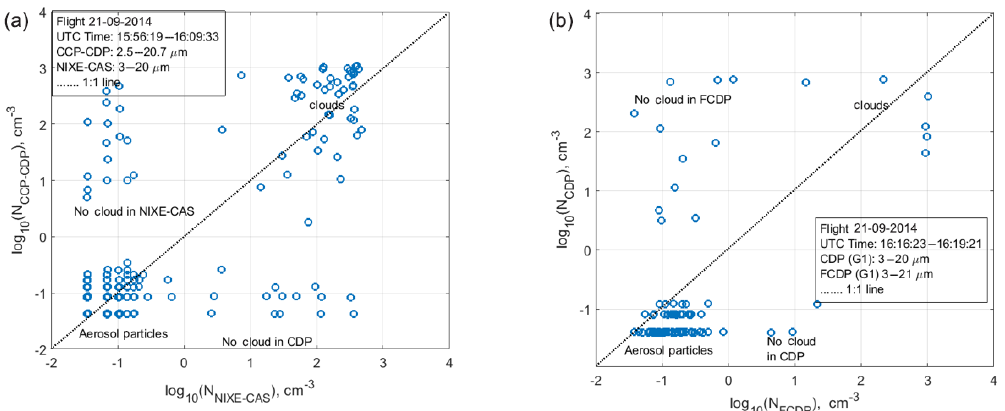
Figure 14. The comparison of cloud droplet concentrations in the same aircraft (a) between NIXE-CAS and CCP-CDP aboard HALO; (b) between CDP and FCDP aboard the